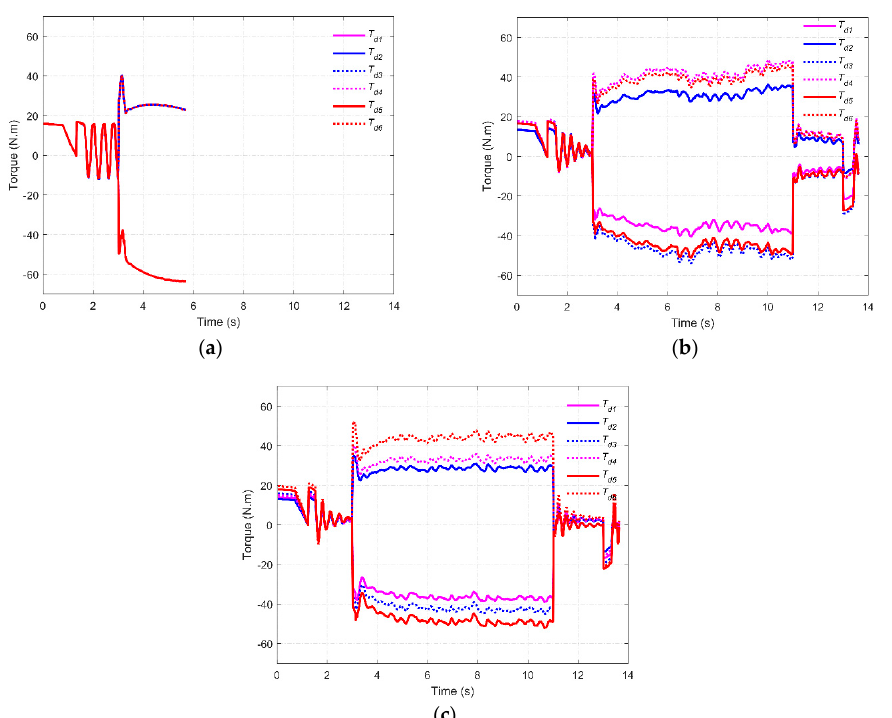
Figure 17. Torque on each wheel with three controllers: ( a ) Torque on each wheel with Ref1 controller; ( b ) Torque on each wheel with Ref2 controller; ( c ) Torque on each wheel with the proposed controller.